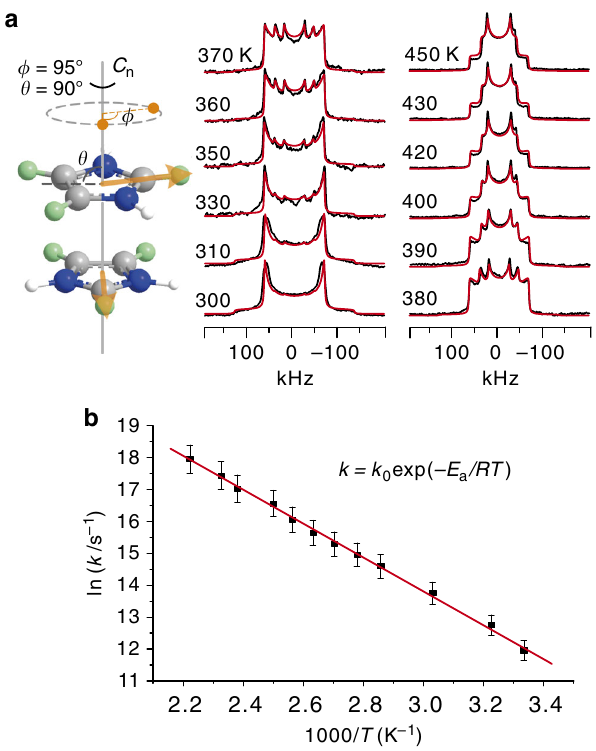
Fig. 6 Solid-state 2 H NMR spectra and analysis. a Simulated (red) and experimental (black) 2 H NMR patterns of 1-d 3 . The experimental temperature varies from 300 to 450 K. The cartoon illustrates the in-plane reorientation motion of the Im cation. A two-site jump motion model is used for the 2 H pattern simulation (see the cartoon in a ), in which ϕ is the jump angle, that is, the reorientation angle, and θ is the angle between the “ rotation ” axis C n and the visual plane containing the Im ring. The two orange points are the two jump sites of a speci fi c deuterium atom in the visual plane. In the simulation, a rigid signal component has been added to the simulated patterns. b Arrhenius plot of the reorientation rates, k , were obtained from the simulated 2 H NMR spectra via Weblab (http://weblab. mpip-mainz.mpg.de/weblab). The error bars represent an uncertainty of 5% of the jump/reorientation rates from the pattern